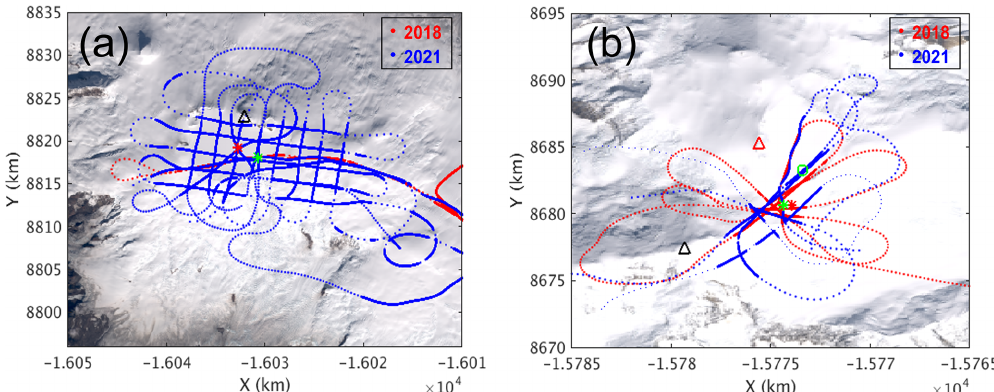
Figure 4. Data coverage over (a) Mount Wrangell and (b) Mount Bona summit areas plotted on the Landsat image maps. The dots with visible spacing depict flight lines and the dots without visible spacing represent the locations with snow layer/snow–ice interface/snow–rock interface observations. The red and blue dots represent the flight lines of 2018 and 2021,